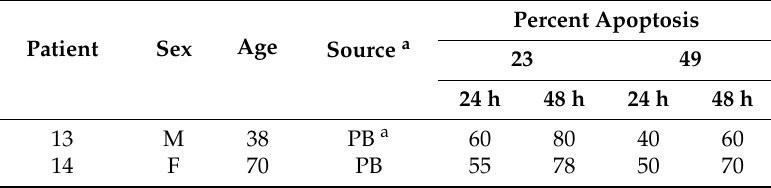
Table 3. Apoptotic activity of 23 and 49 in cells from CML patients in blast crisis and Imatinib-resistant at onset at 10 μ M.